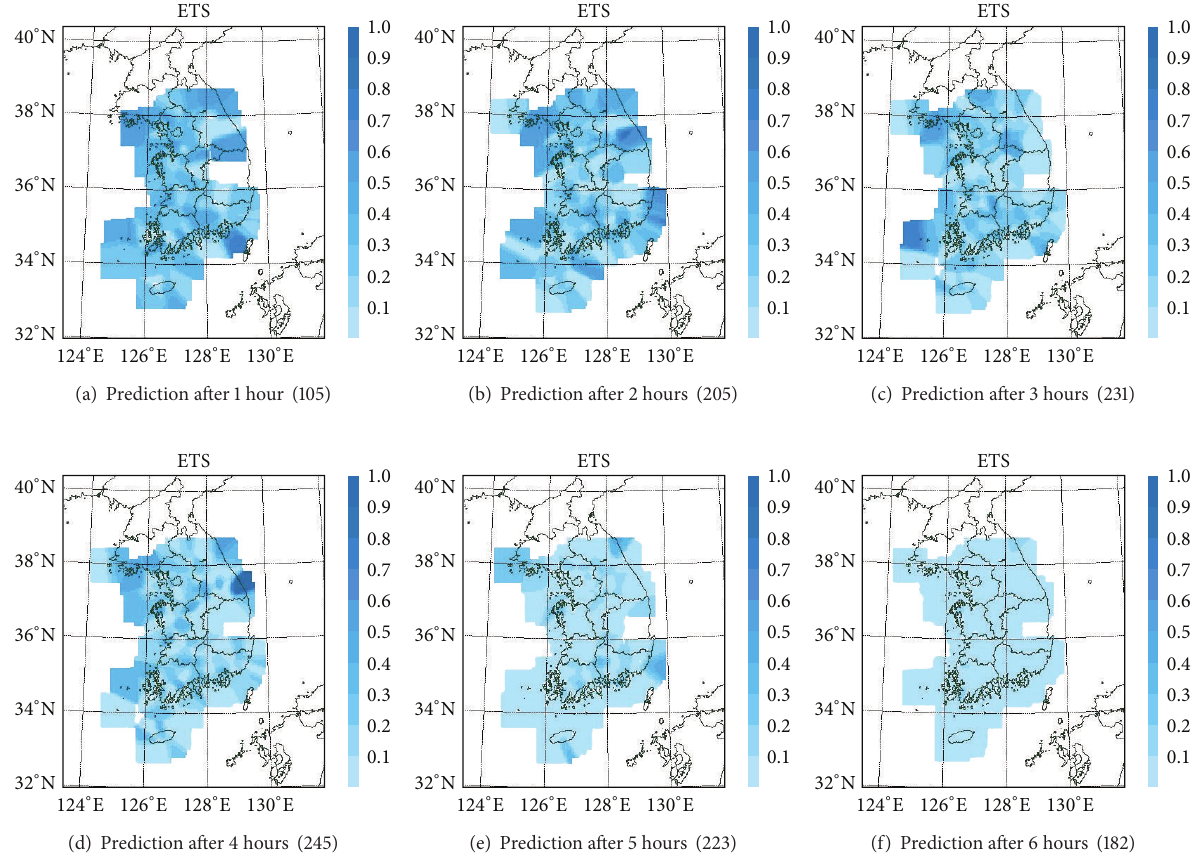
Figure 10: Individual maps, with AWS in blue dots, for GA heavy rainfall prediction after from 1 to 6 hours